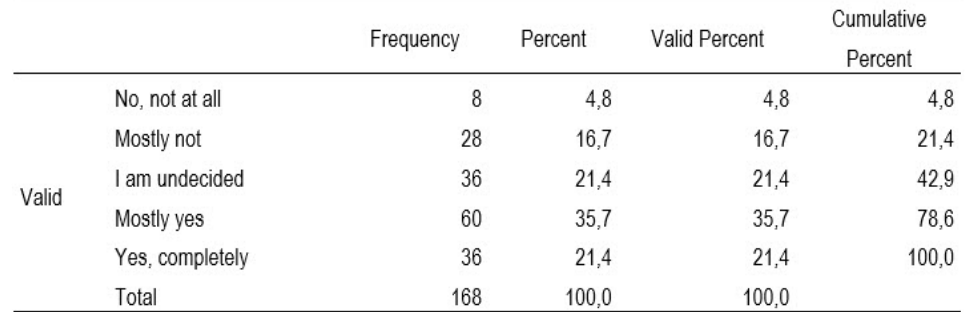
Break and inability to attend preschool can have a negative effect on children’s intellectual